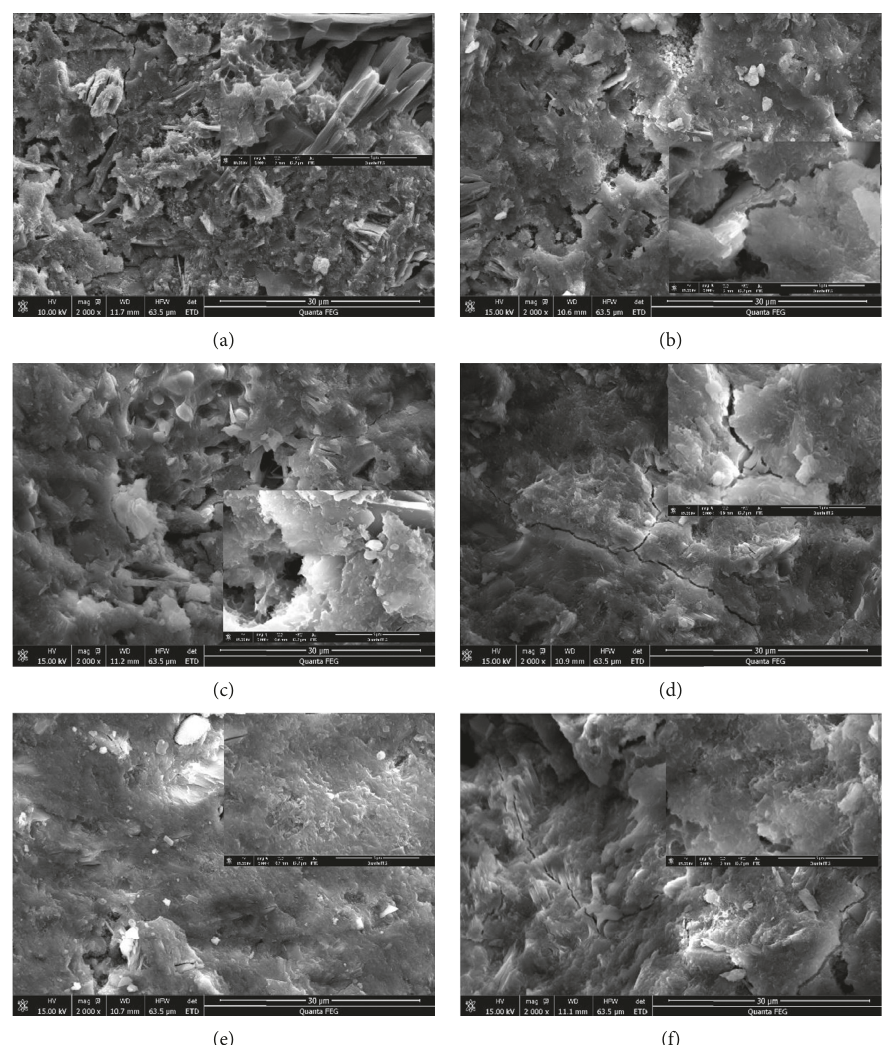
Figure 7: SEM images of specimens cured for 28 days: (a) B2-0min-35%, (b) C2-20 min-35%, (c) D1-40min-20%, (d) D2-40min-35%, (e) D3-40 min–50%, and (f)